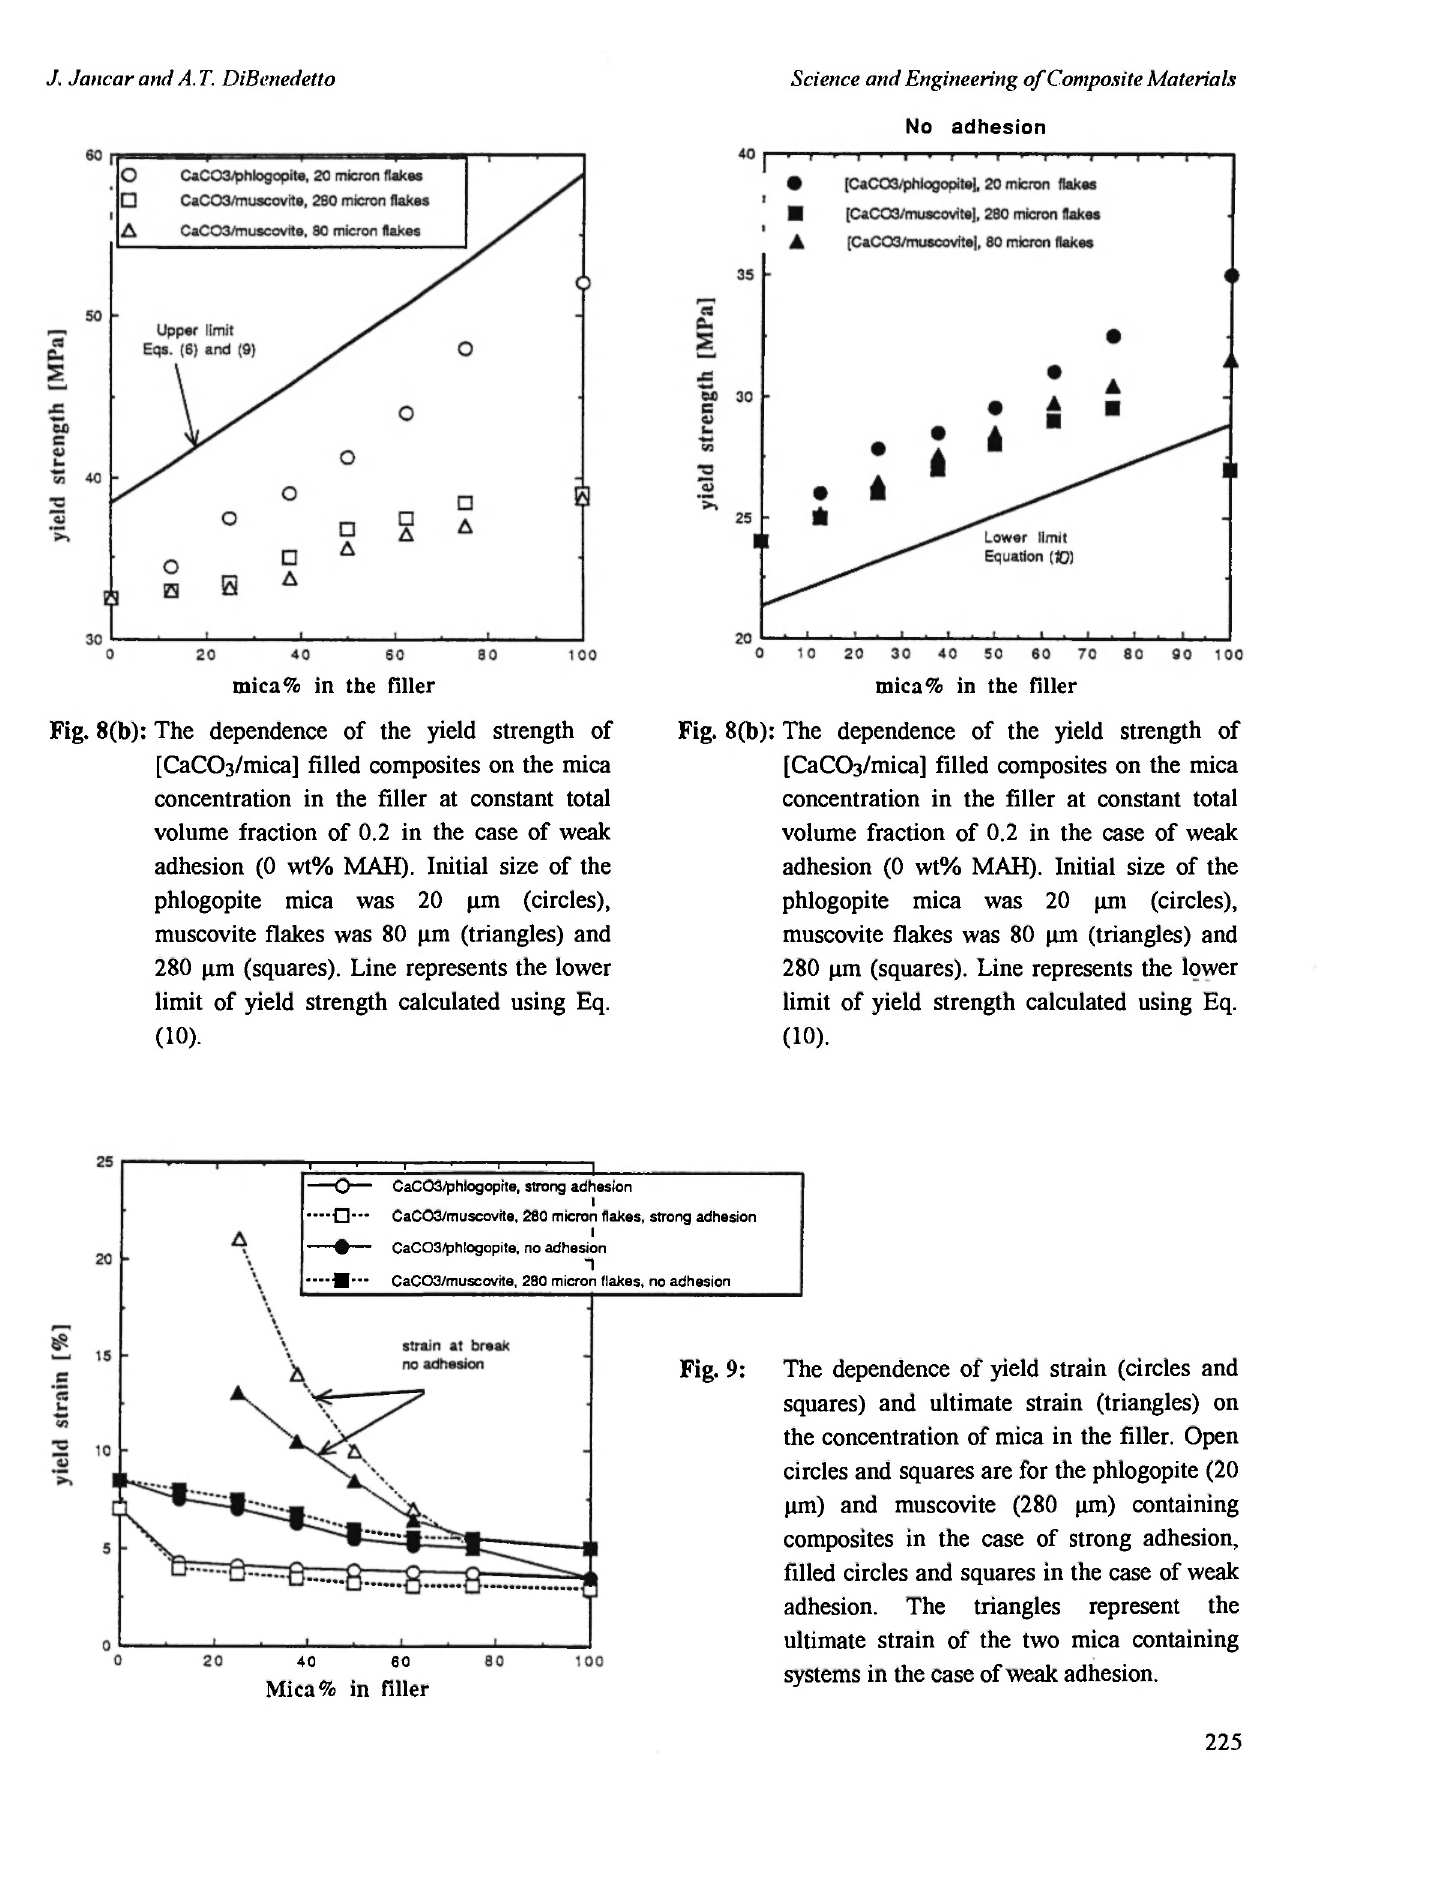
Fig. 9: The dependence of yield strain (circles and squares) and ultimate strain (triangles) on the concentration of mica in the filler. Open circles and squares are for the phlogopite (20 μπι) and muscovite (280 μπι) containing composites in the case of strong adhesion, filled circles and squares in the case of weak adhesion. The triangles represent the ultimate strain of the two mica containing systems in the case of weak